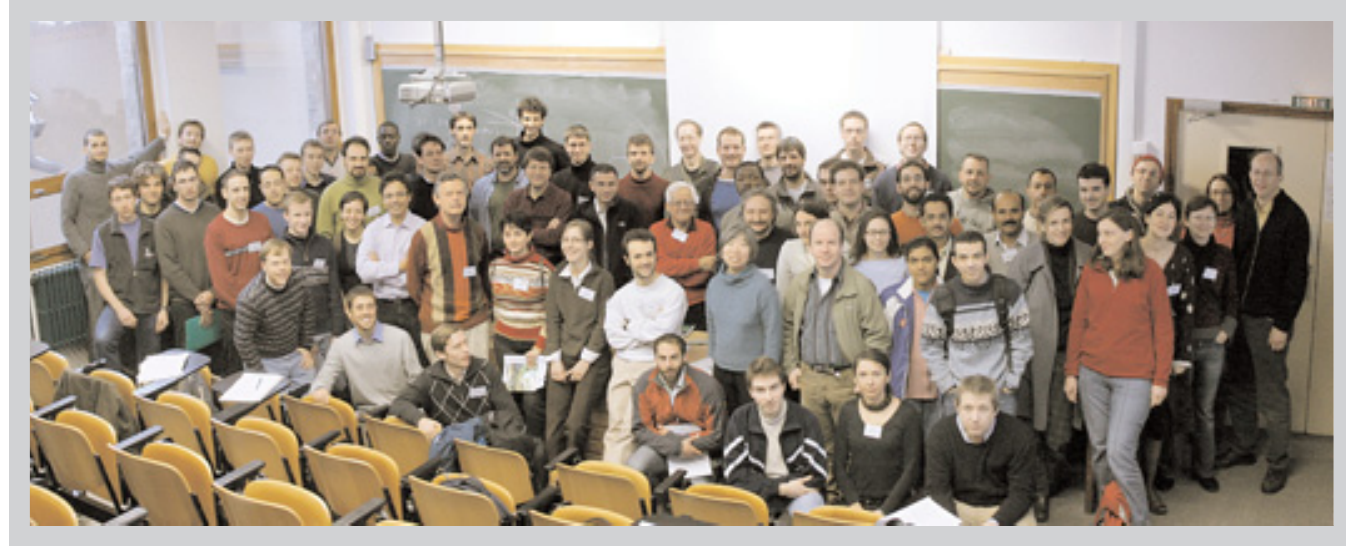
Figure 1 (left): The participants in the con- ference room. (Photo: F. Mahaut) Figure 2: Our view from the confer- ence center. (Photo: F.